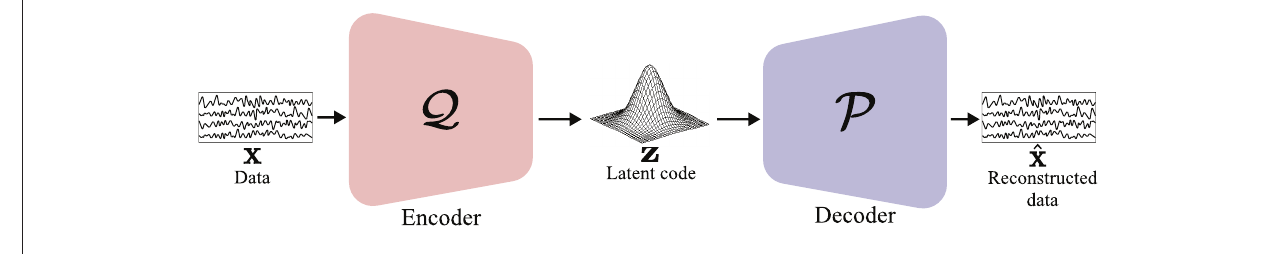
FIGURE 6 | Illustration of variational autoencoder (VAE) (Kingma and Welling, 2014). Encoder Q learns latent space of input data x . From the learned latent space, latent code z is sampled and input to decoder P . Finally, decoder P reconstructs input data ˆ x .